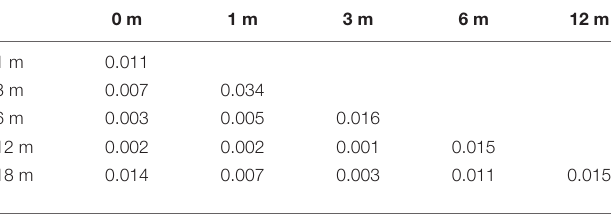
Average length of implantation age follow-up (M) (¯x ± SD)